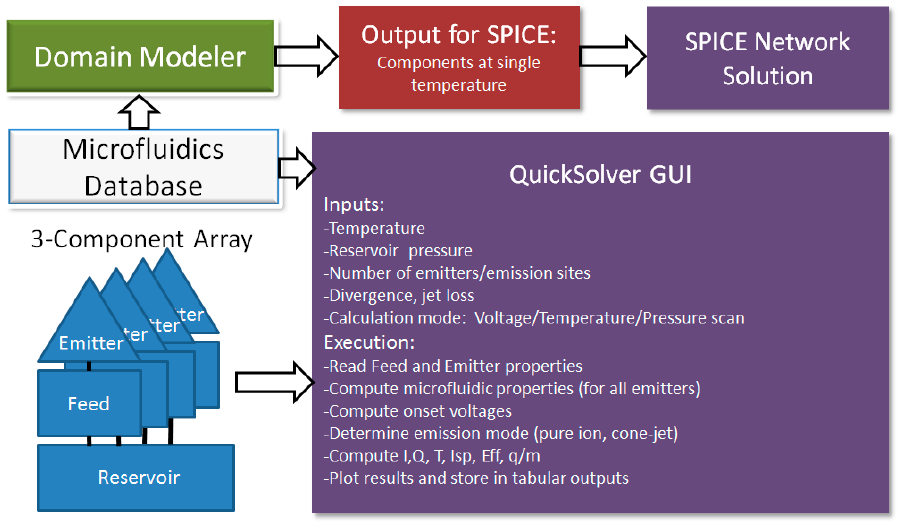
Figure 3. Overview of ESPET structure and process flow.